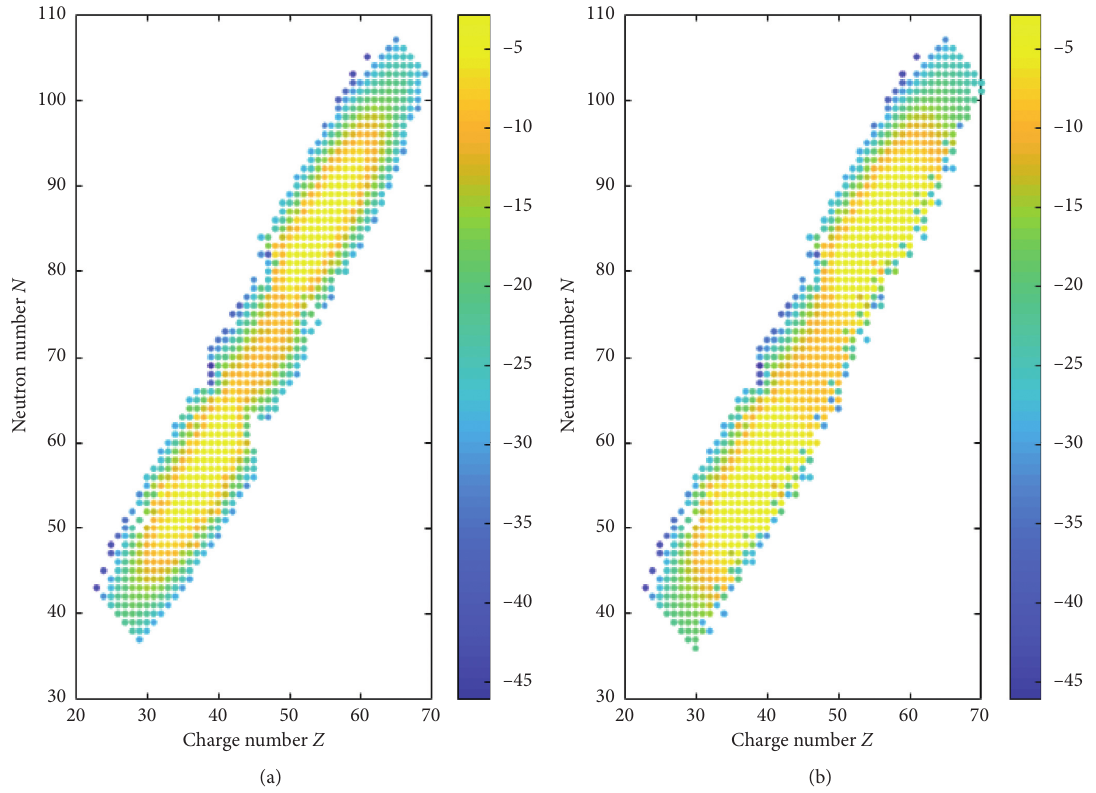
Figure 2: Thermal neutron induced U-235 fission yield data in ENDF/B-VII.1. The natural logarithm values of fission yields are plotted. (a) Independent yields. (b) Cumulative